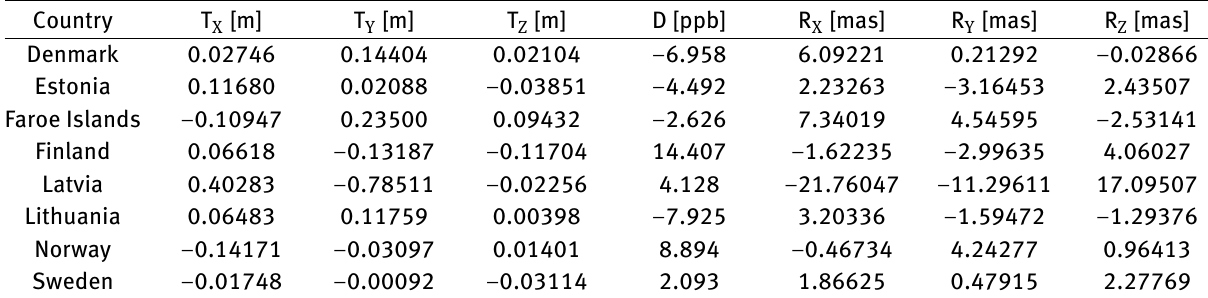
Table 9: Transformation parameters P NKG 2, CC from the common NKG reference frame NKG ETRF 00 to national ETRS89 realizations at the epoch 2000.0, ETRFyy(2000.0). Transformation is defined and parameters given at the epoch 2000.0. Parameters P NKG 2, CC are associated and should be used only with intraplate corrections from the original NKG RF 03 vel model, see Fig. 2 for more